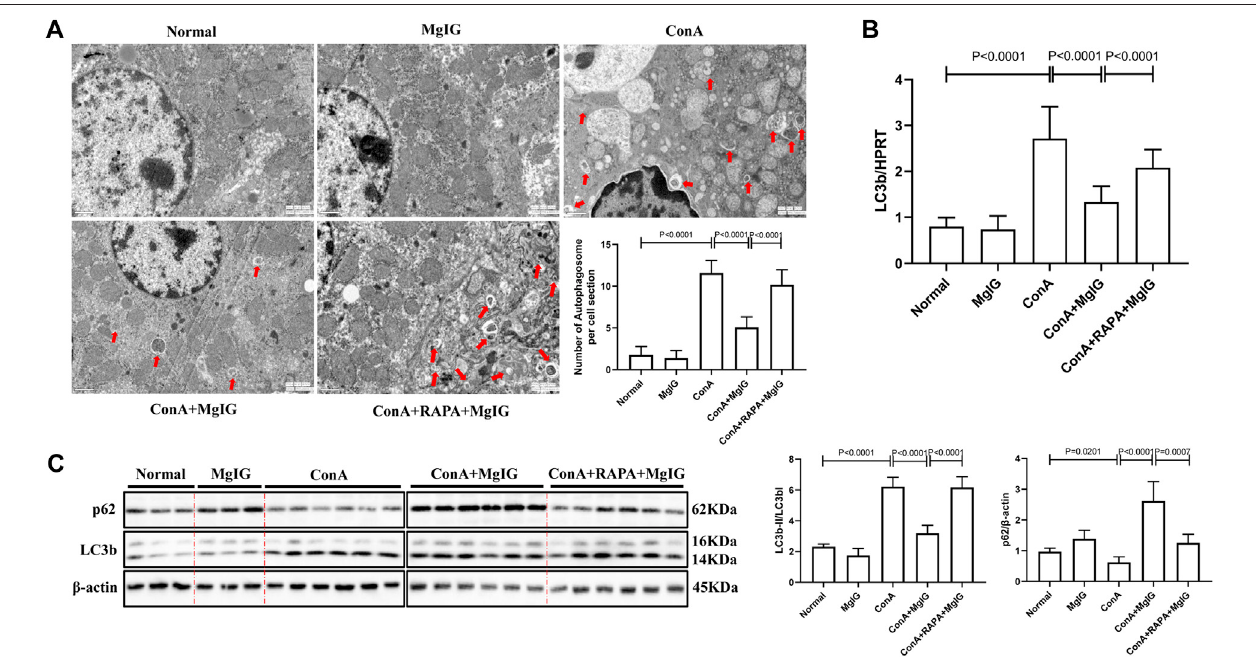
FIGURE2| MgIGinhibitsliverautophagyinducedbyConA.ThedataareshownasthemeanandSDofatleastthreeindependentexperiments. (A) Representative electron microscopy image of autophagosomes in the mouse liver. The arrows indicate autophagosomes (magni fi cation: 15000 × ). (B) qRT-PCR was used to measure the expression level of the LC3b gene in mouse liver tissue, with the housekeeping gene HPRT as a control. (C) The expression levels of autophagy-related proteins, including LC3 and p62, in mouse liver tissues were measured by western blotting, with β -actin as a control.